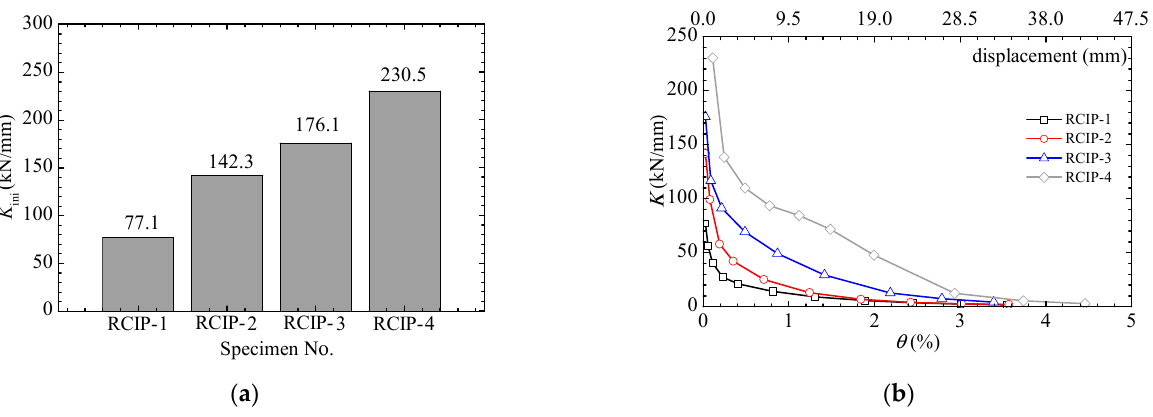
Figure 14. Lateral stiffness degradation of test specimens: ( a ) initial lateral stiffness; ( b ) lateral stiffness degradation curves.